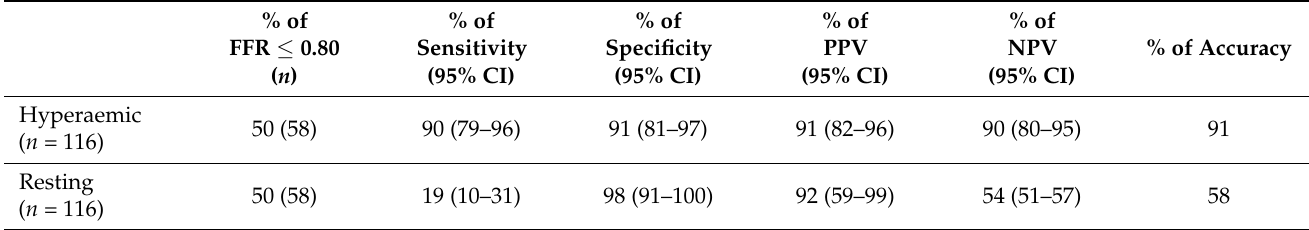
Table 1. Diagnostic performance and accuracy of δ dP n /dt ≤